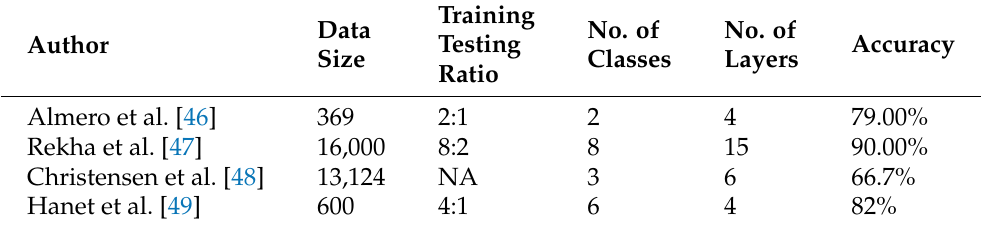
Table 1. Summary of previous research.